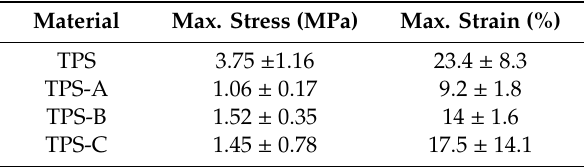
Table 2. Tensile tests results for pure TPS and its composites.